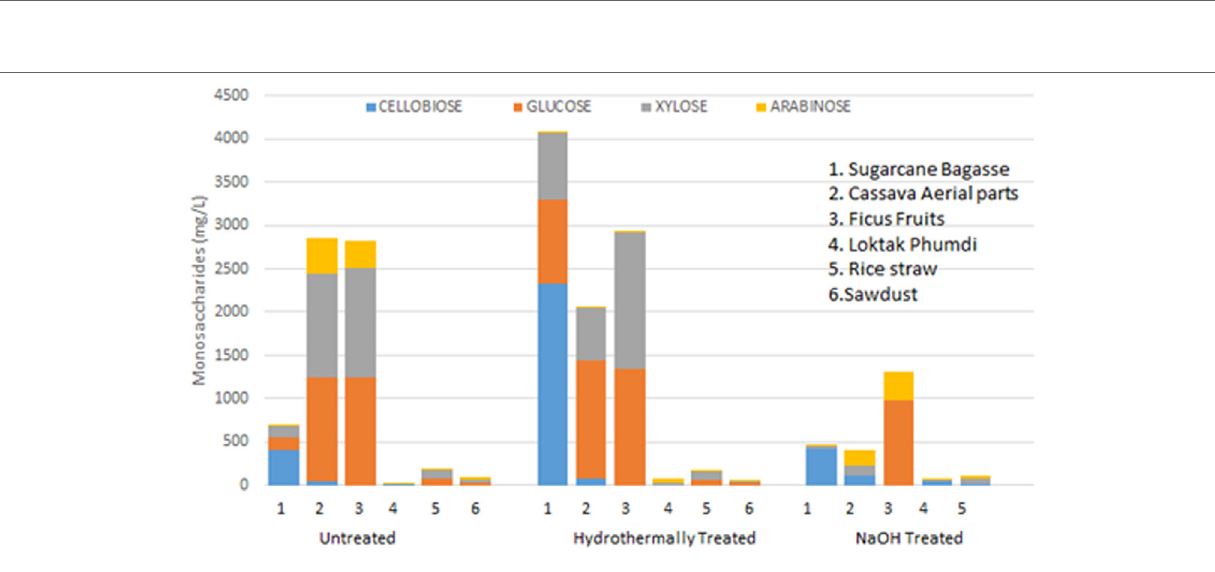
FigUre 4 | Monosaccharide and disaccharide composition (expressed in milligram per liter) in the liquor fraction before and after pretreatments of six lignocellulosic biomass and respective native biomass (control).